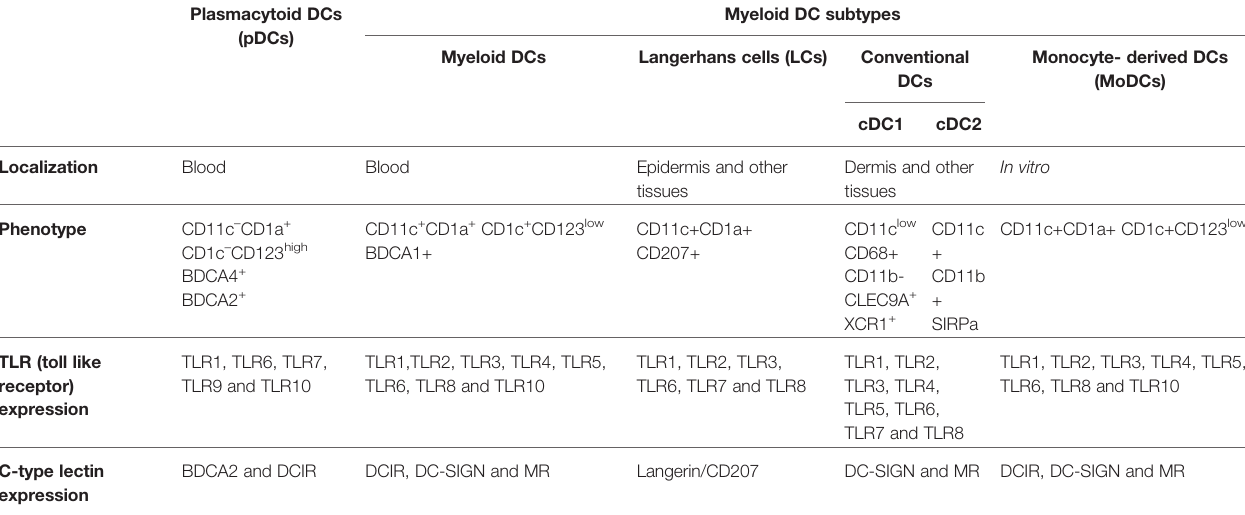
TABLE 2 | Phenotypic and functional markers of human blood and tissue dendritic cell